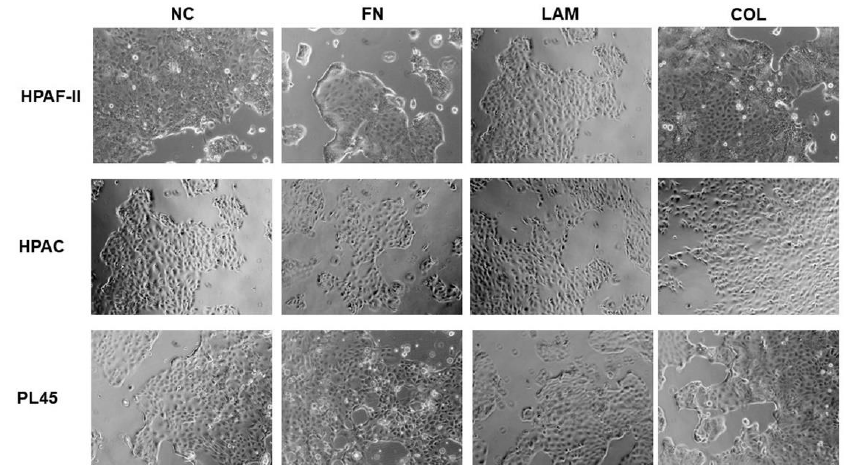
Figure 1. Cell morphology. Photomicrographs at the inverted microscope showing the epithelial morphology of HPAF-II, HPAC, and PL45 cells grown on fibronectin (FN), laminin (LAM), COL-I (COL), or without coating (NC) (original magnification 10×).